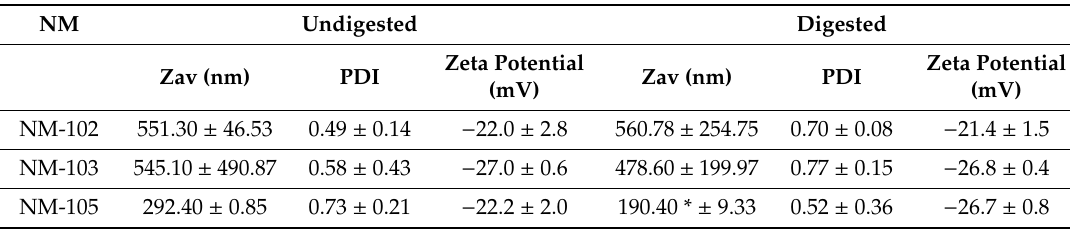
Table 2. DLS measurements of hydrodynamic mean size (Zav, nm), polydispersity index (PDI) and surface charge (Zeta potential, mV) of the nanomaterials (NMs) dispersions in cell culture medium (14 µ g / mL), with and without digestion simulation. Results are presented as mean ± SD ( n = 3).